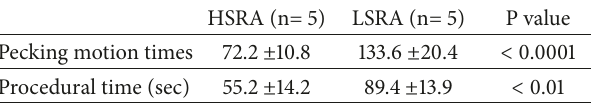
Table 1: In-vitro